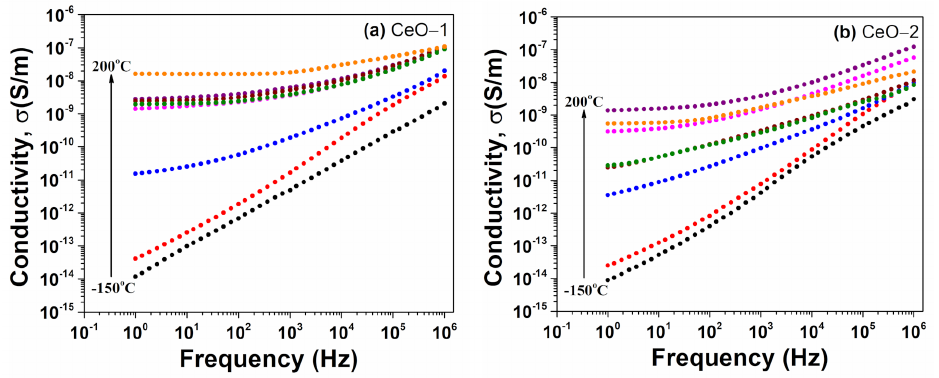
Figure 9. Variation of conductivity versus frequency at various temperatures for cerium oxide nanoparticles ( a ) CeO-1, ( b )